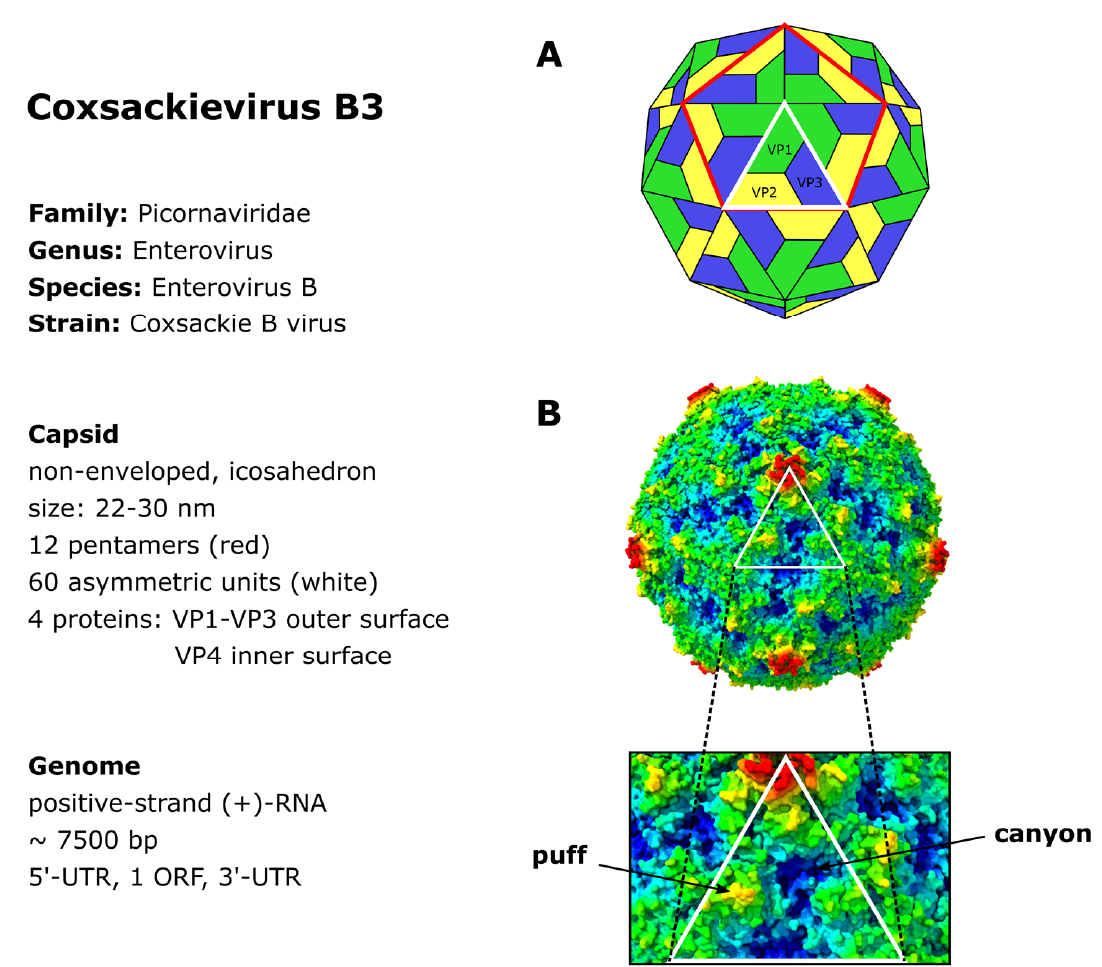
Figure 1. Structure of the CVB3 capsid. ( A ) A schematic model of the icosahedral CVB3 capsid structure composed of 60 asymmetric units, each composed of one VP1 (green), VP2 (yellow), VP3 (blue) and VP4. VP1, VP2 and VP3 form the capsid surface, while VP4 is located on the inside surface. The red outlined area depicts a pentamer, the white outlined triangle depicts an asymmetric unit. ( B ) Upper panel : The capsid surface structure colored radially. The radial surface structure was calculated and modelled with the bioinformatic software UCSF ChimeraX [23] based on the structural data of CVB3 RD from the RCSB protein databank (accession no. 4GB3). Lower panel: A magnified section of the asymmetric unit with the arrows highlighting the puff region and the canyon.